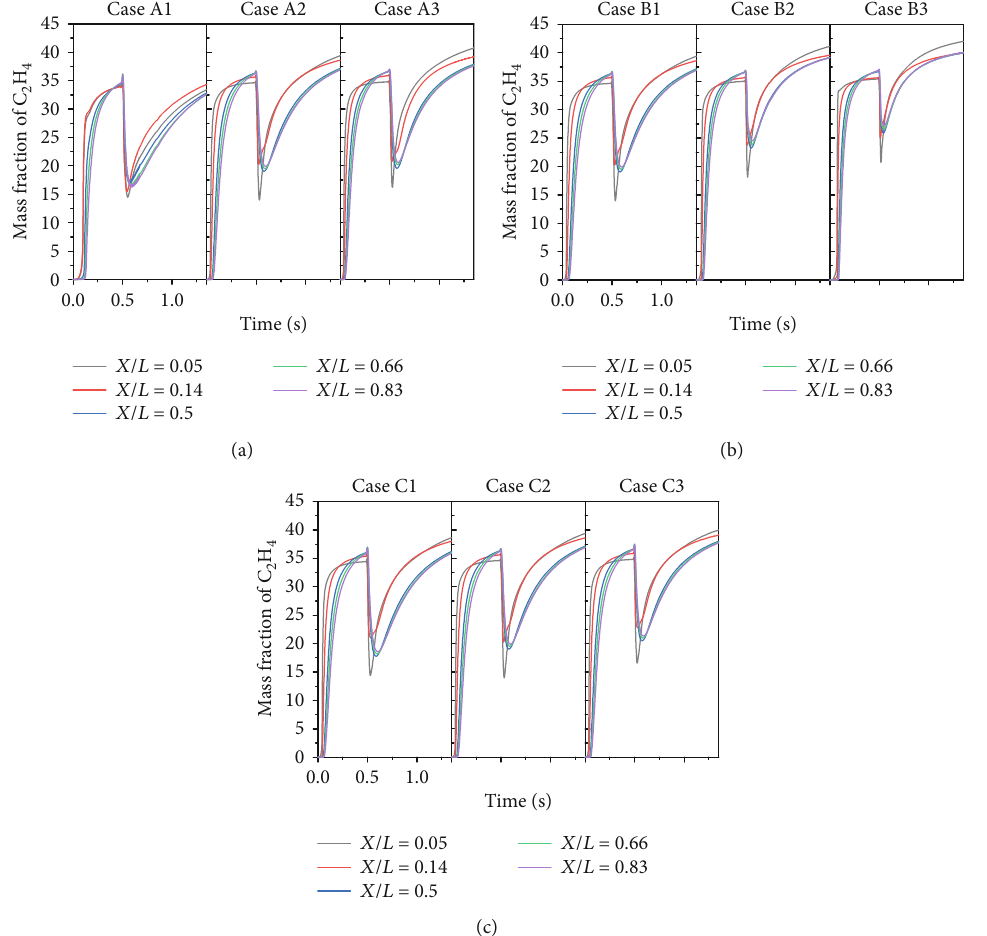
Figure 15: Time trace of the mass fraction of C